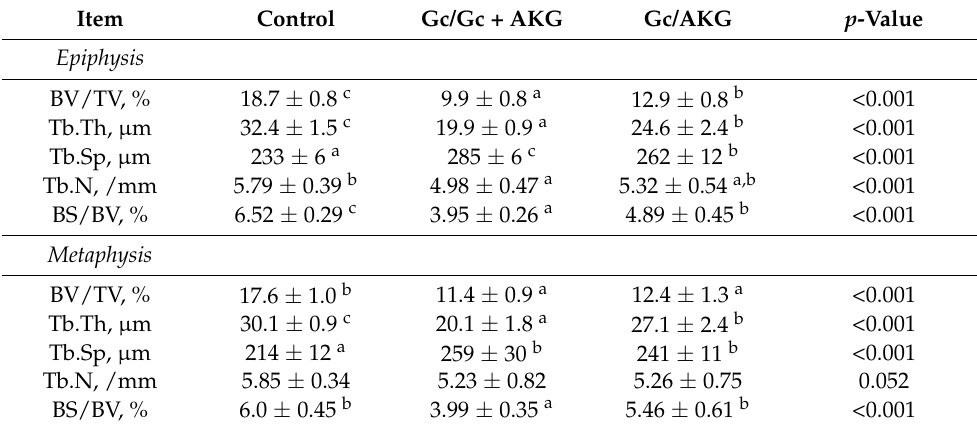
Table 7. Histomorphometry measurements of trabeculea in epiphysis and metaphysis of the femur of 35-day-old piglets.